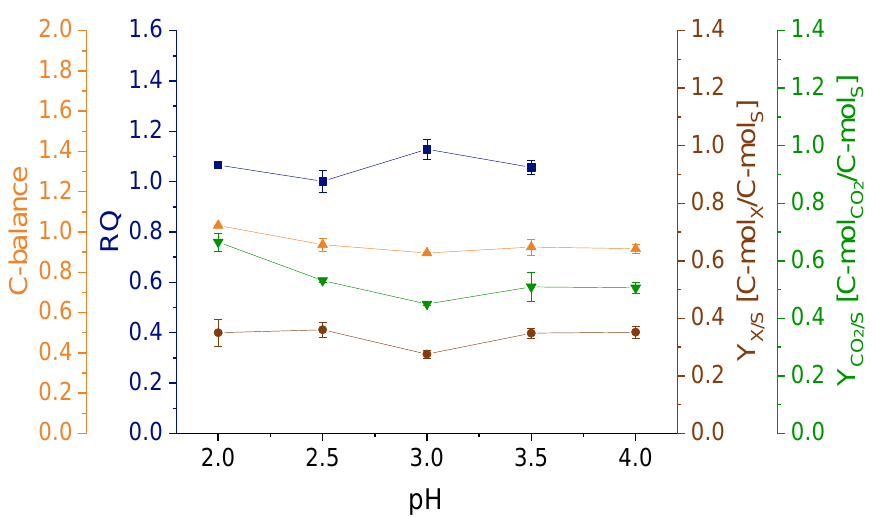
Figure 3. C-balance, respiratory quotient (RQ), biomass yield (Y X/S ) and CO 2 yield (Y CO2/S ) in dependence of the pH value. Error bars indicate the difference between the various sampling points after reaching steady state in the continuous cultivation. The RQ at pH 4.0 could not be calculated due to a malfunction of the O 2 analyzer during the cultivation.